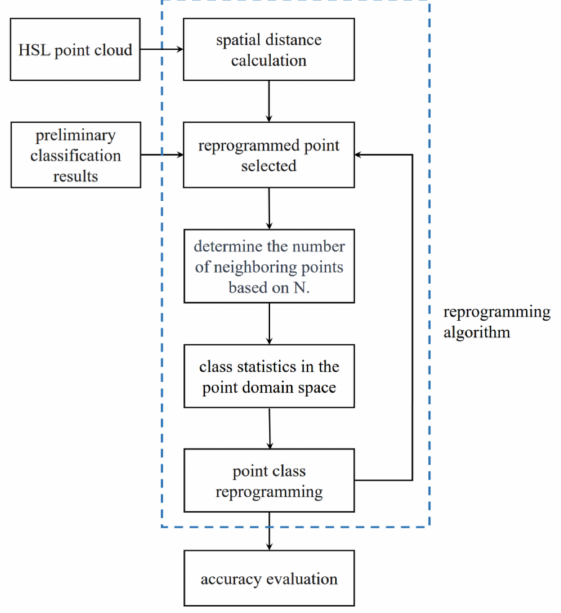
Figure 6. Enhanced reprogramming algorithm based on spatial